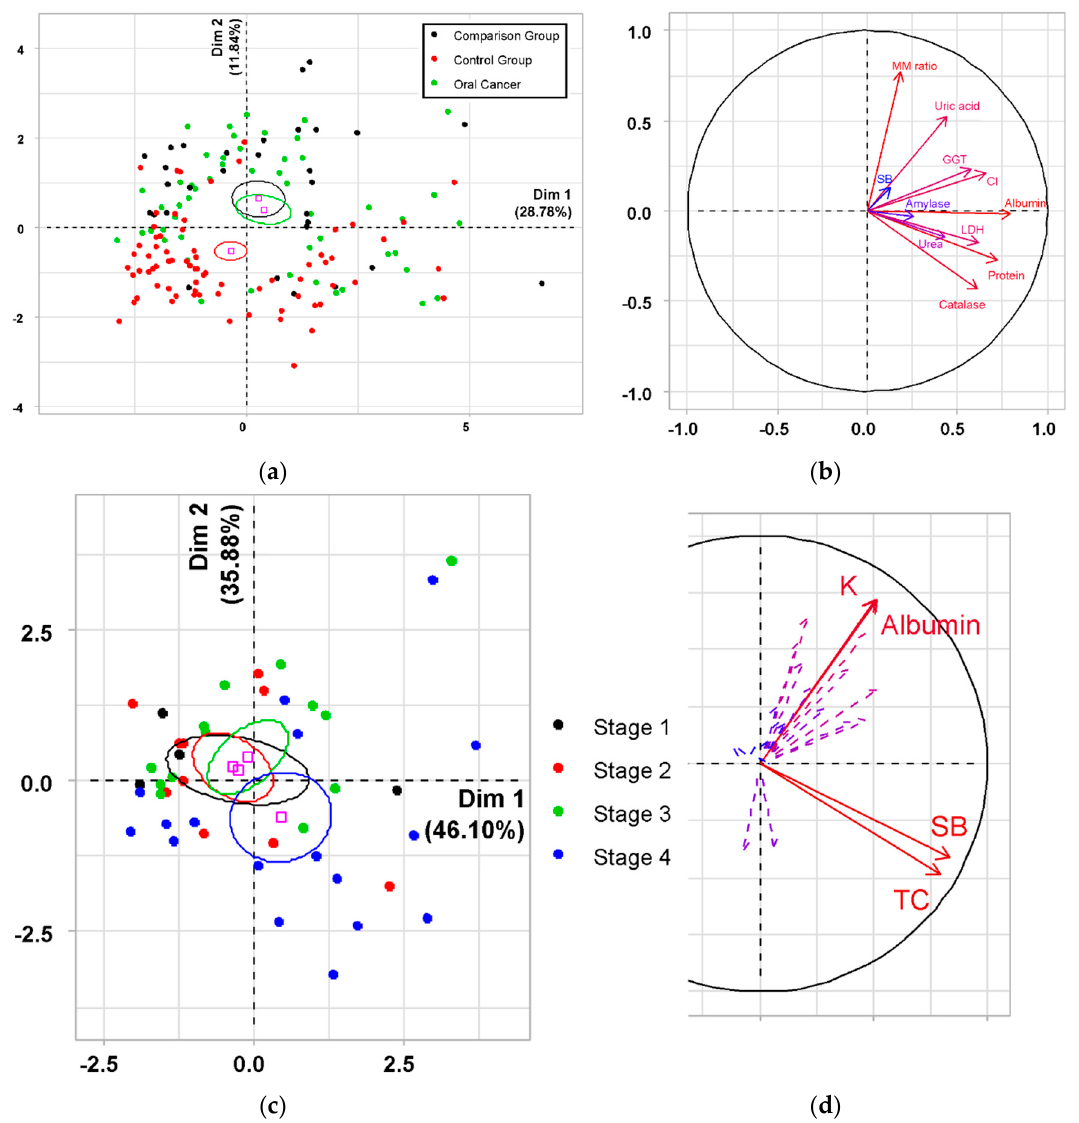
Figure 2. The factor plane ( a ) and the correlation circle ( b ) for groups of oral cancer group, comparison group and control group. The factor plane ( c ) and the corresponding correlation circle ( d ) by stages of oral squamous cell carcinoma (OSCC). On the correlation circle, the variables are sorted by importance level in color from blue (0) to red (1).